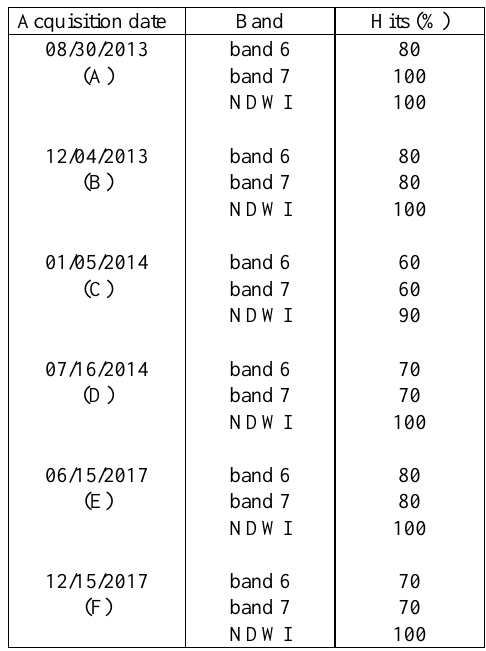
Table 2. Accuracy evaluation for clustering with band 6, band 7 and NDWI for each analyzed